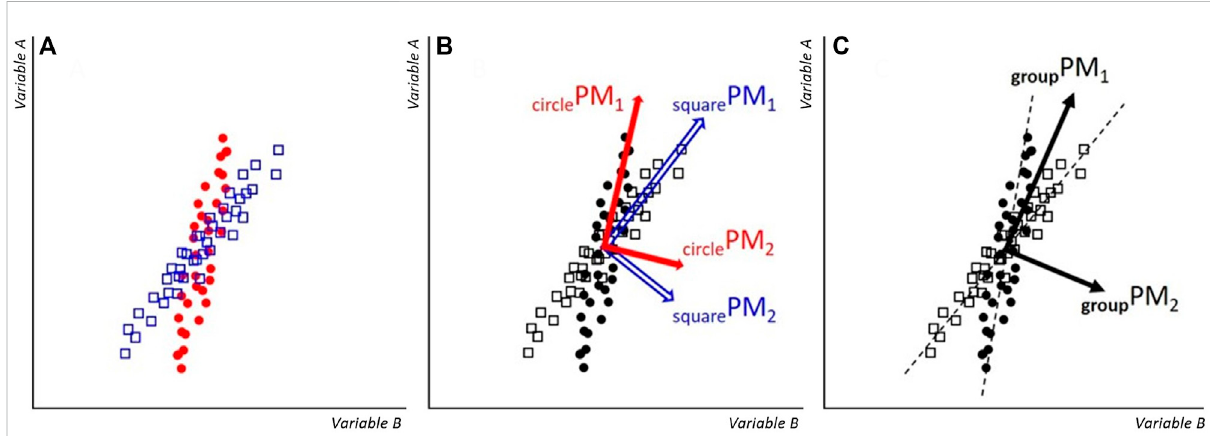
FIGURE 3 Schematic: (A) exampledatapointsof ‘ VariableA ’ and ‘ VariableB ’ fromvolunteers “ square ” and “ circle ” .Sincetheyperformthemovementnotin exactly the same way, the orientation of the data point clouds are slightly rotated against each other. (B) When individual-level PMs are calculated, then each PM-coordinate system aligns with the orientation of the speci fi c data cloud. Thus, the correlation between PM 1 and PM 2 will be zero for the data of each volunteer. (C) Group-level PMs are calculated for the entire dataset. For each volunteer, group PM 1 is a close approximation of the main movement pattern, however, a small fraction of the volunteer ’ s main movement pattern also gets projected onto group PM 2 . Therefore,